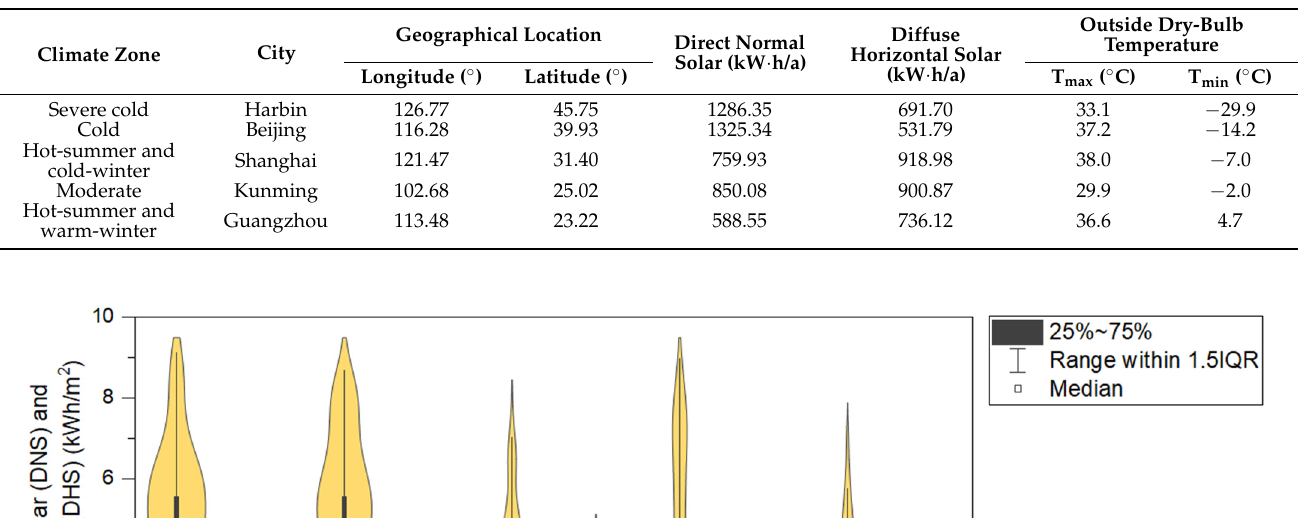
Table 4. Meteorological data of typical cities in five climate zones.